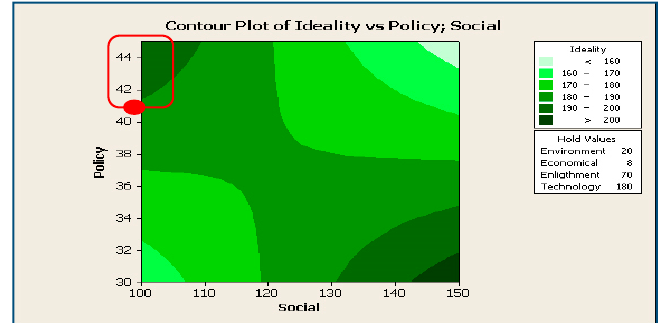
Figure 9. Impact of environment and enterprises technology interference.